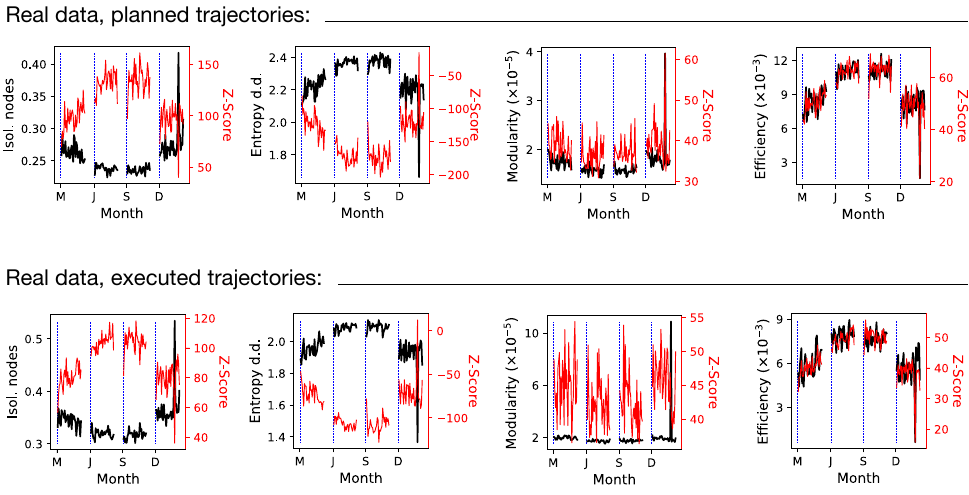
Figure 5. Properties of the interaction networks for planned ( top panels) and executed ( bottom panels) trajectories, as a function of time. See Figures A8 and A9 for full results. Black ( left Y axes) and red lines ( right Y axes), respectively, correspond to the raw values of the metrics and their Z-Scores. The vertical blue dotted lines represent the beginning of each month. M: March; J: June; S: September;